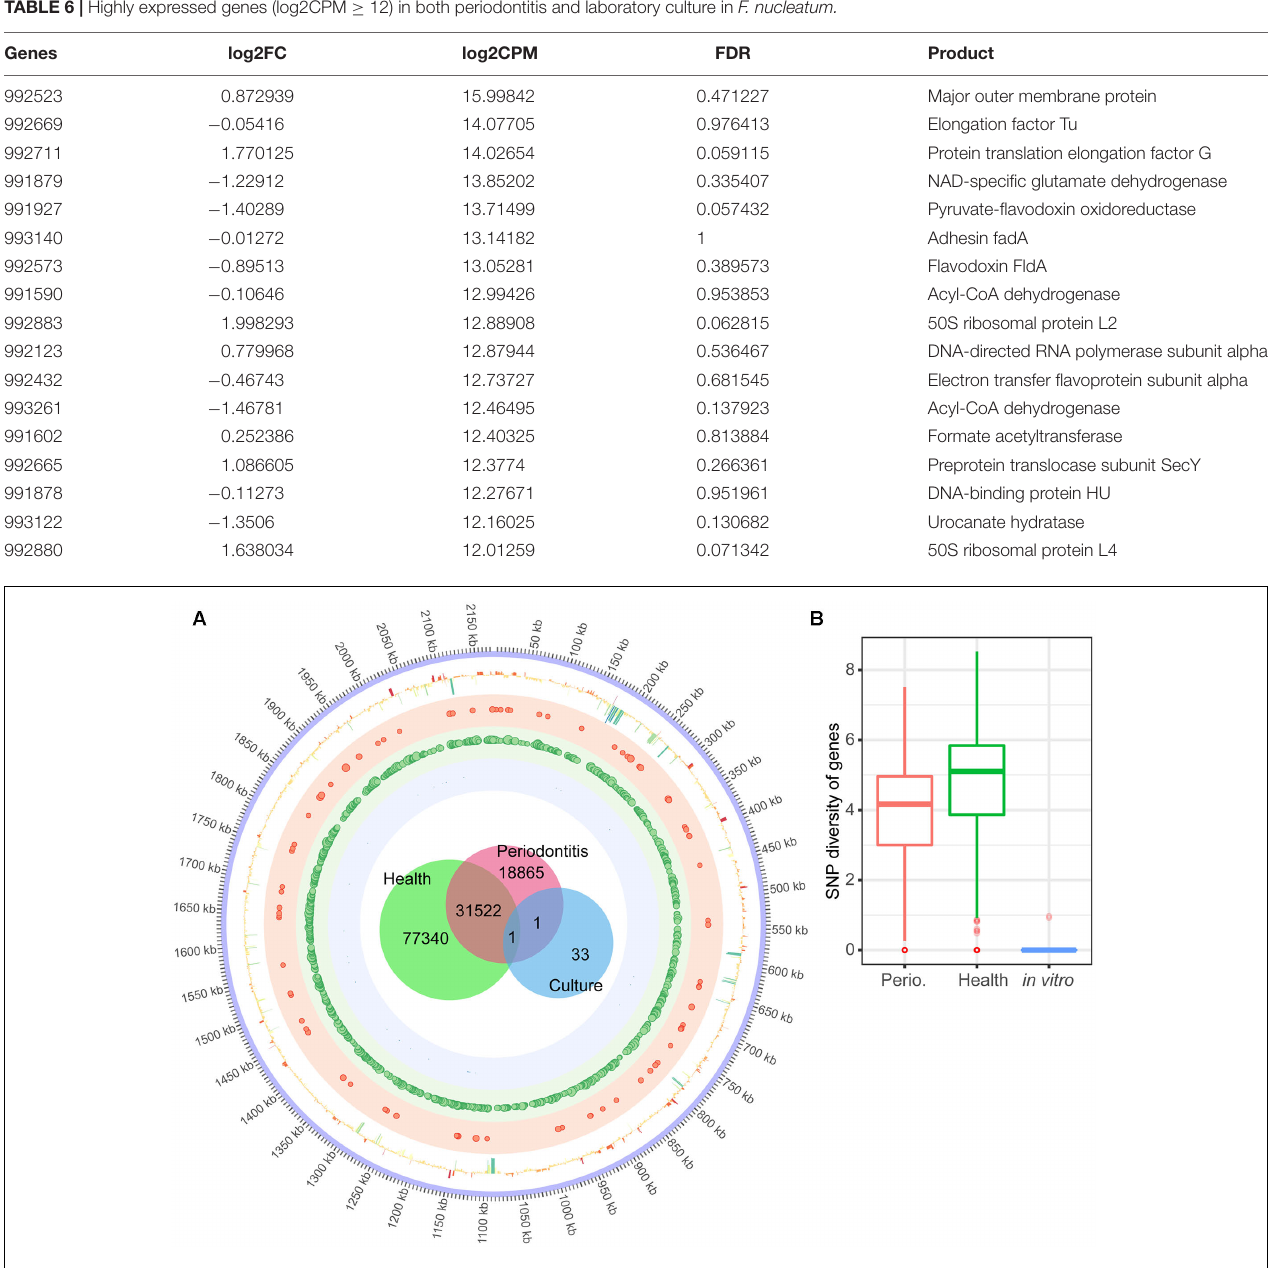
FIGURE 4 | Single Nucleotide Polymorphisms (SNPs) in the transcriptome of F. nucleatum in the periodontal niche and in laboratory culture. (A) The innermost Venn diagram shows the number of SNPs of F. nucleatum transcripts in the periodontal community of individuals with periodontitis, without periodontitis, and laboratory culture. The circle shows the SNPs mapped to the genome of F. nucleatum. Size of the dots in the shaded red, green and blue circles illustrates the frequency ( > 50) of variants in a 1 kb window of F. nucleatum in periodontitis, health and laboratory culture, respectively. The outermost circle shows the log2FC of each gene in periodontitis compared to laboratory culture. (B) Frequency of SNPs per gene calculated as Shannon diversity (see Section “Materials and Methods” for details). The median, inter quantile range and outliers are shown in the